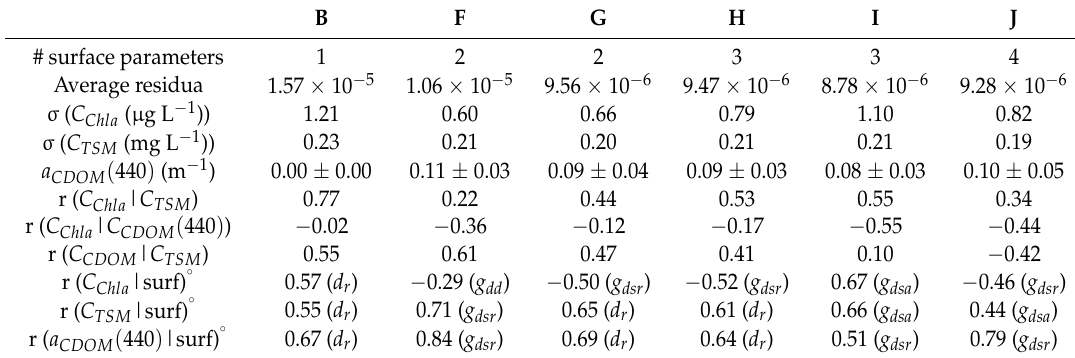
Table 3. Comparison of the variability (standard deviation σ ) and the correlation (Spearman’s rank correlation coefficient r) of water constituents retrieved from 260 above-water measurements for the surface reflectance correction approaches (B and F–J). These were the approaches that showed a reasonable spectral matching during inversion (compare Table 2).